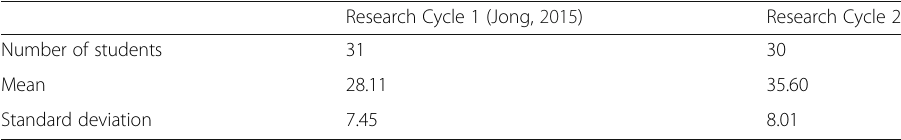
Research Cycle 1 (Jong,